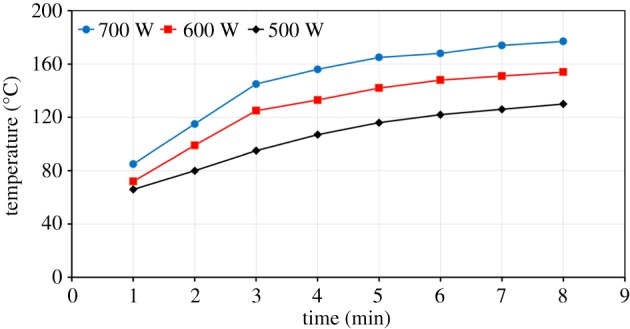
Effect of the microwave power level on the heating rate of ZnFe2O4.